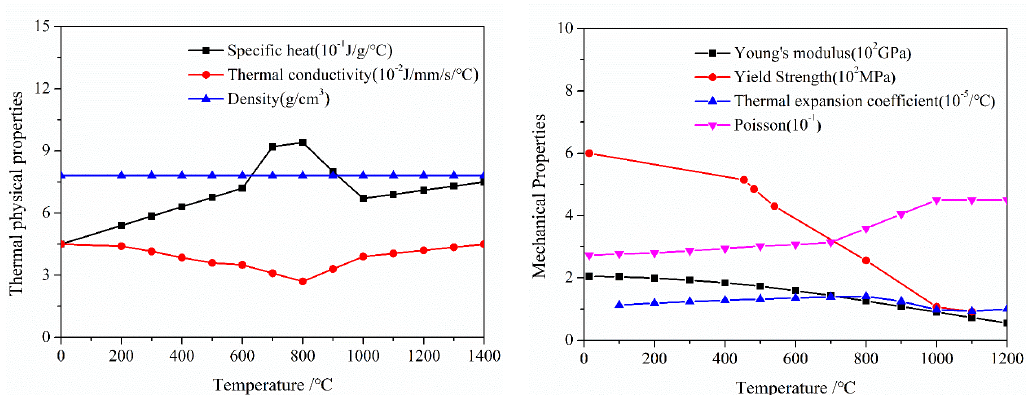
Figure 5. Temperature dependency of ( a ) thermal physical and ( b ) mechanical parameters of 2.25Cr–1Mo–0.25V.